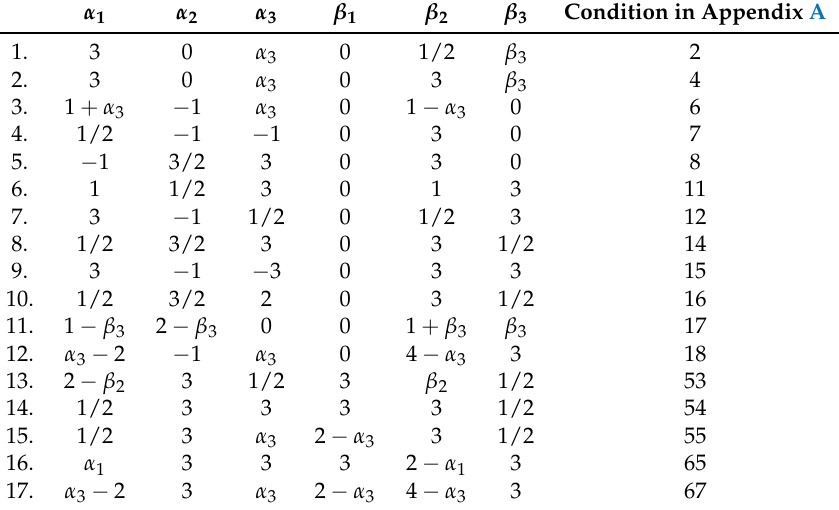
Table 1. Parameter values for systems with invariant surfaces not passing through the